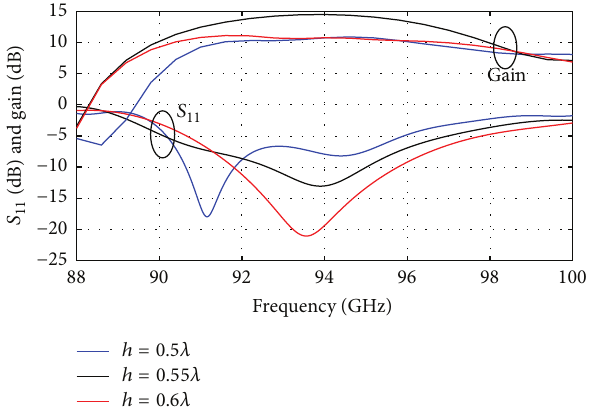
Figure 12: Results of 𝑆 11 , gain, and directivity over frequency with an optimised superstratedimension 𝑆 = 2×2𝜆 0 , an optimised height 𝑡 = 0.127 ℎ = 0.6𝜆 0 , and an optimised thickness